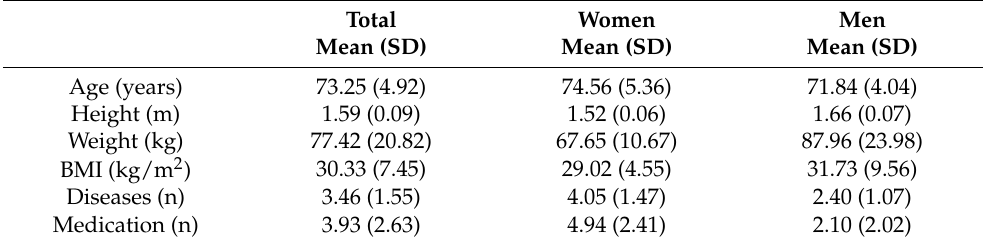
Table 1. Sociodemographic characteristics.